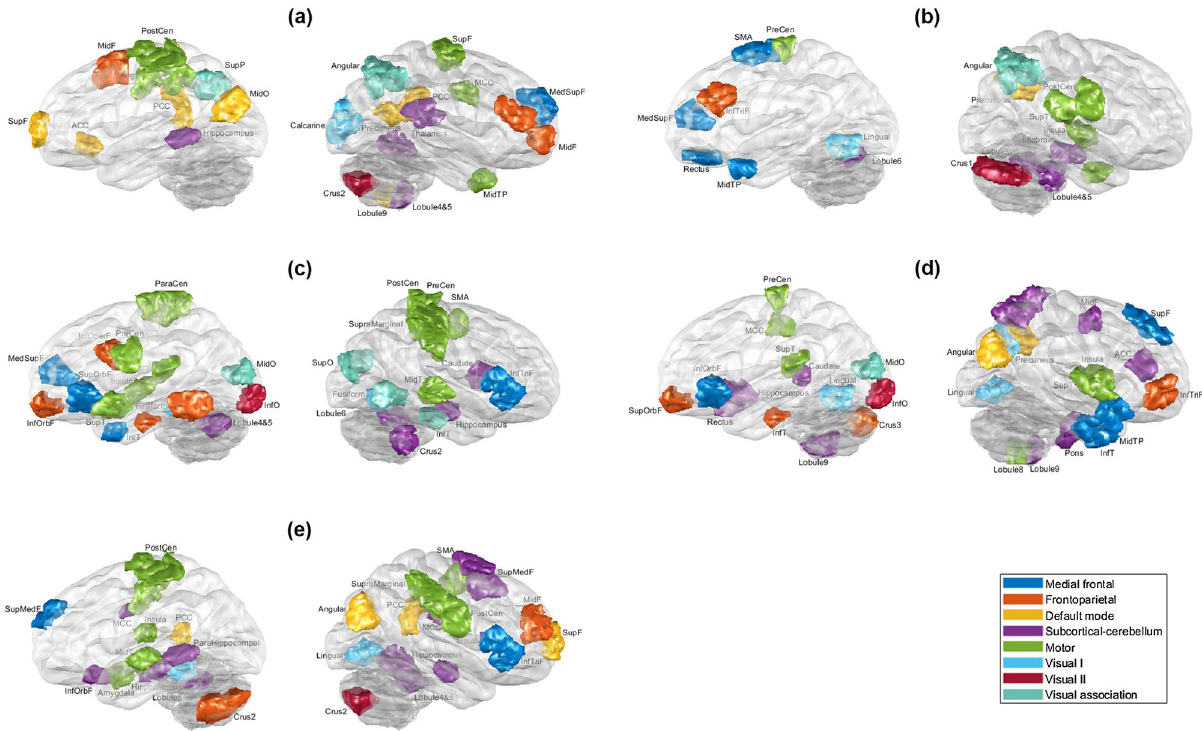
Figure 3. The involved regions of major features of the classification analyses for fewer and more occurrences groups based on the number of episodes, the number of hospitalizations, suicide attempts, and having psychosis or not, which were selected more than 90 times after 100 times of processing of minimum redundancy maximum relevance selection during the outer loop of the nested cross-validation, as illustrated on the glass brain. ( a ) The involved regions of major features of the classification for the number of episodes. ( b ) The involved regions of major features of the classification based on the number of hospitalizations. ( c ) The involved regions of major features of the classification based on suicide attempts. ( d ) The involved regions of major features of the classification based on the history of psychosis. ( e ) The involved regions of major features of the classification based on diagnostic subtypes. ( ACC anterior cingular cortex, InfO inferior occipital cortex, InfOperF inferior opercular frontal cortex, InfOrbF inferior orbitofrontal cortex, InfT inferior temporal cortex, InfTriF inferior triangular frontal cortex, MCC middle cingular cortex, MidF middle frontal cortex, MidO middle occipital cortex, MidTP middle temporal pole, ParaCen paracentral lobule, PCC posterior